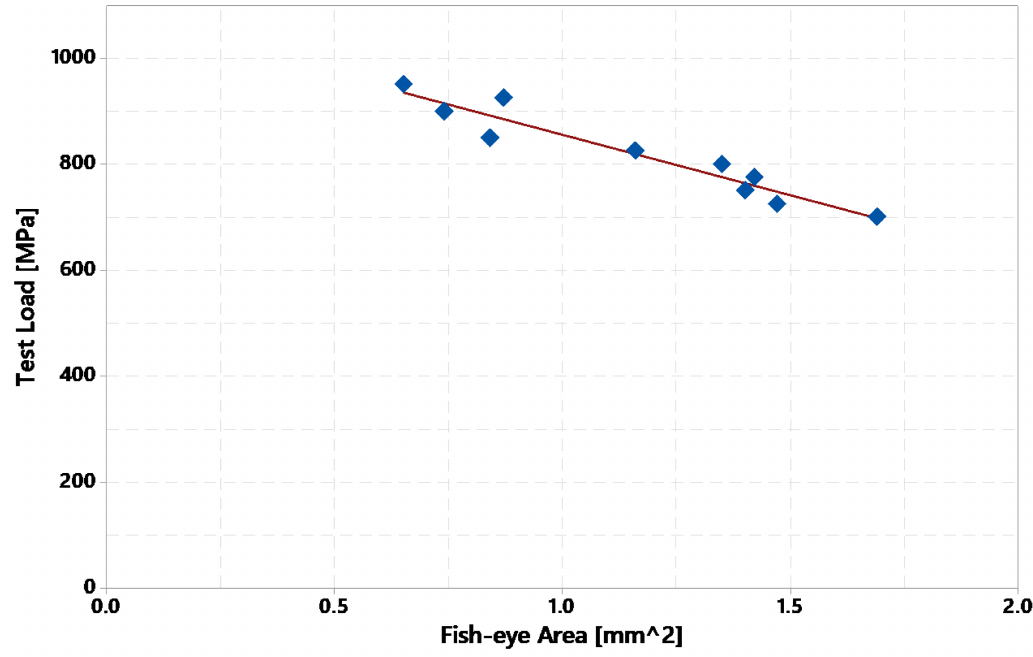
Figure 15. Scatter Plot of the correlation between fish-eye area and test load.